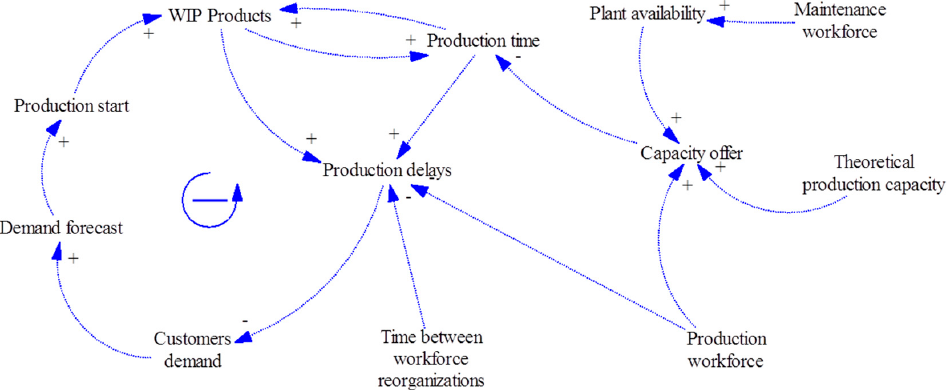
Figure 8. CLD for the production system.